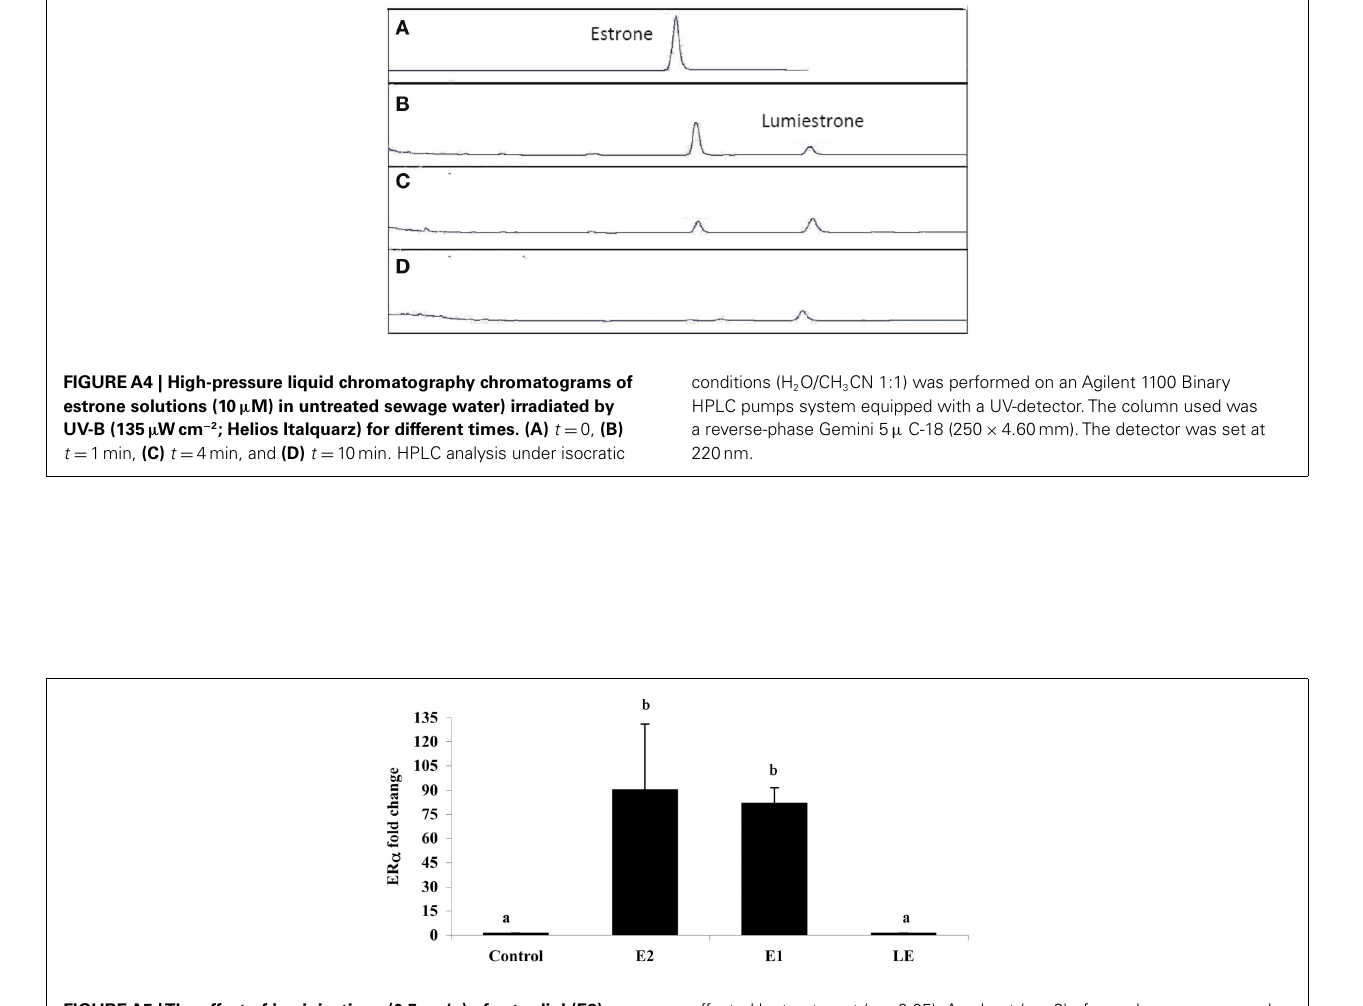
affected by treatment ( p > 0.05). A subset ( n = 3) of samples was screened by SYBR-Green-based PCR for vitellogenin-1 (VTG-1).VTGs are abundant phosphoproteins normally produced in the female liver that are released into circulation and accumulate in developing oocytes to provide nourishment for developing fish larvae.The gene is largely silent and undetectable in males unless they are exposed to estrogenic chemicals. respectively 0 (not-detectable), 4.2, 5.9, and 0